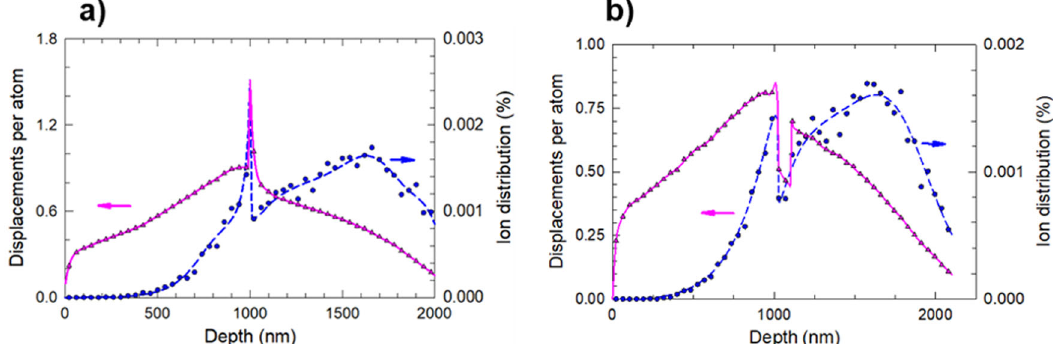
Fig. 3 Calculated damage pro fi le for high energy Au implantation into both sets of fi lms. SRIM predicted dpa pro fi le to an ion fl uence of 1 × 10 14 cm − 2 (left axis) and implanted ion distribution (right axis) for 11.5 MeV Au ions into a 1 μ m HEA fi lm on Si and b 1 μ m HEA fi lm on SiO 2